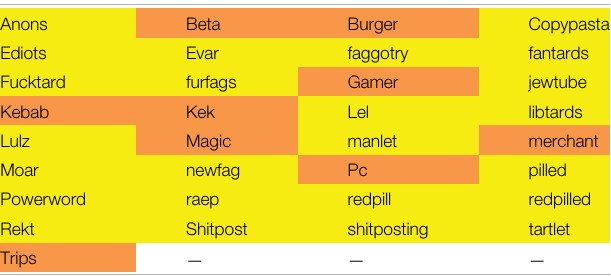
TABLE 1 | Words collected from the top 200 changing and new words on both 4chan/pol/and ED, after fi ltering for misspellings, proper names, duplicates, and other noise. Non-representative order. Words detected by novelty marked in yellow; words detected by change marked in orange.